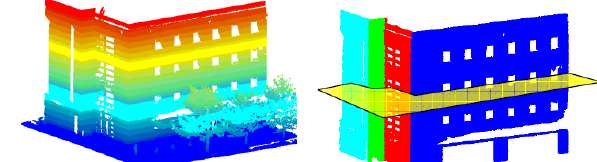
Figure 7. building outlines extraction from 3D TLS points (Source: Wang and Sohn, 2001)